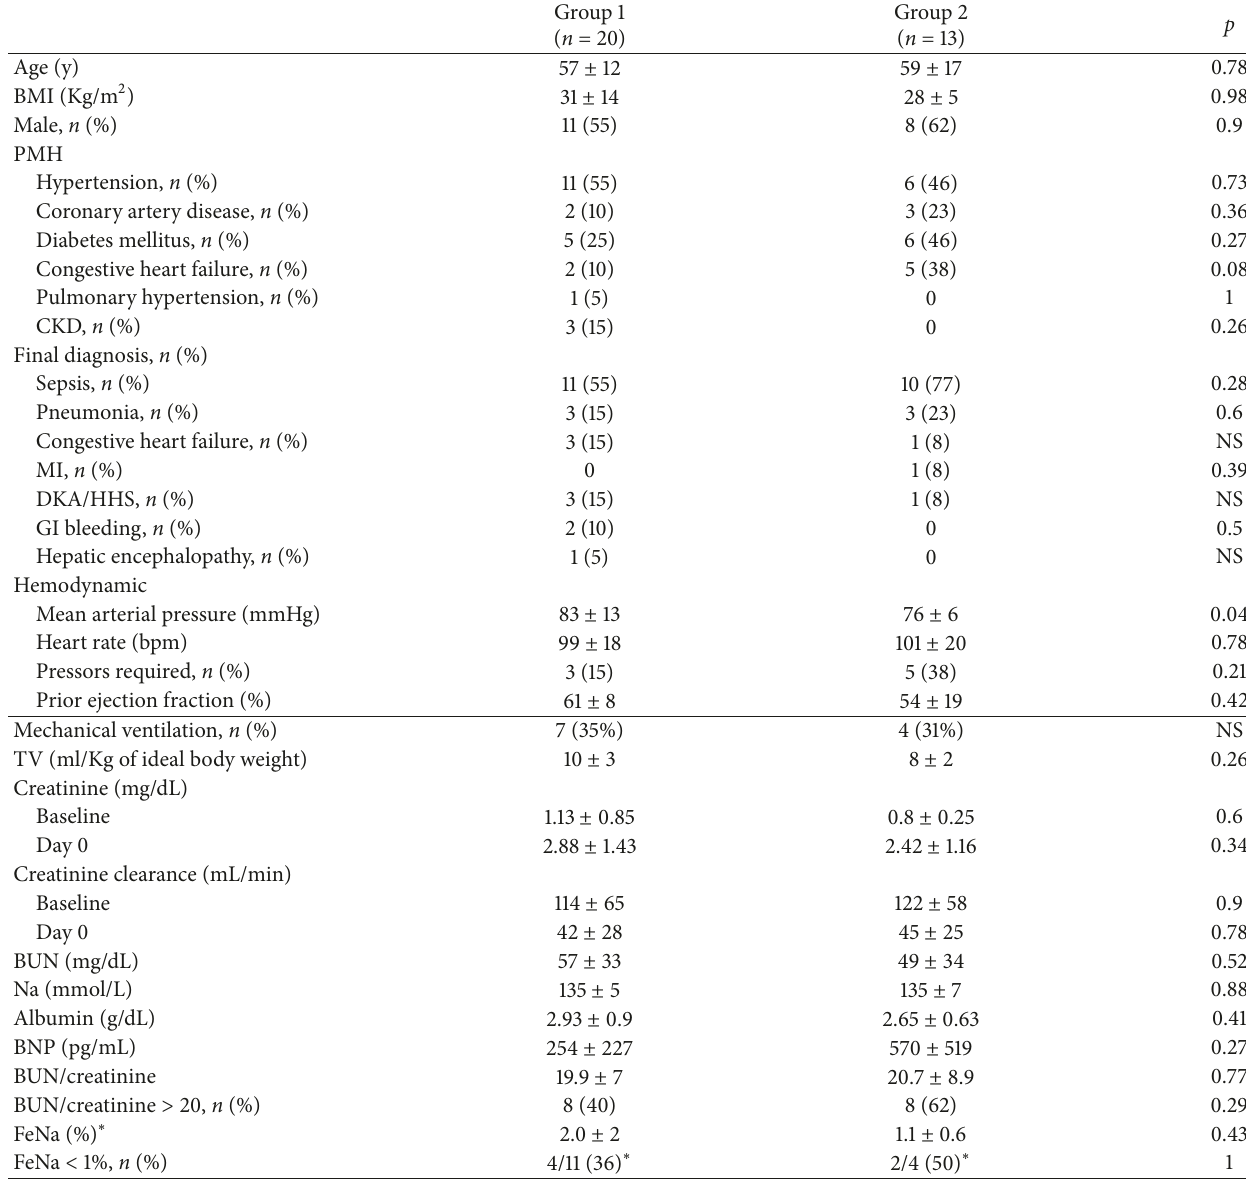
Table 2: Baseline characteristics of the 33